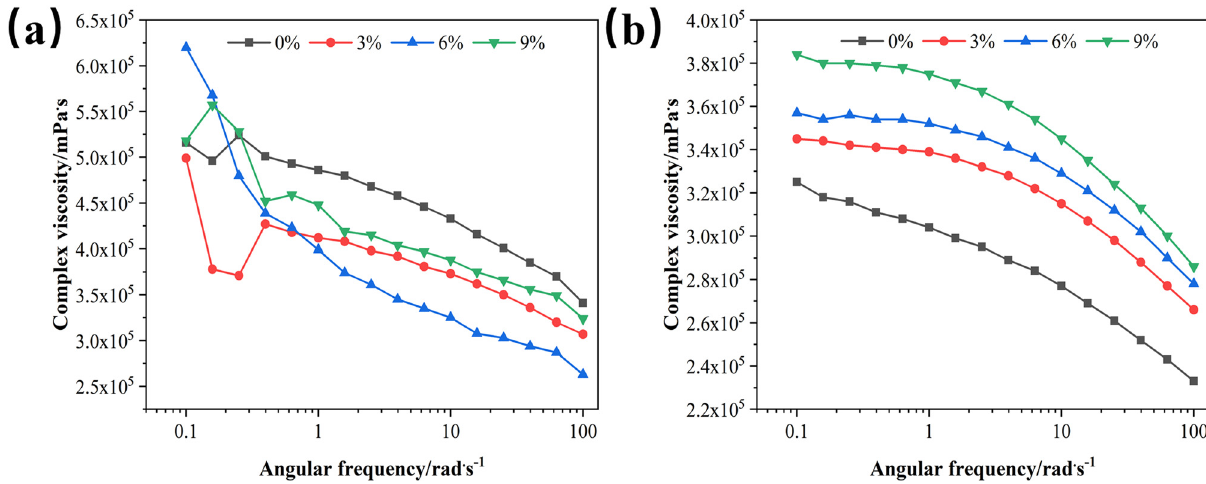
Figure 7: Complex viscosity of modi fi ed asphalt frequency scanning under di ff erent parallel plates: ( a ) complex viscosity under 8 mm parallel plate and ( b ) complex viscosity under 25 mm parallel